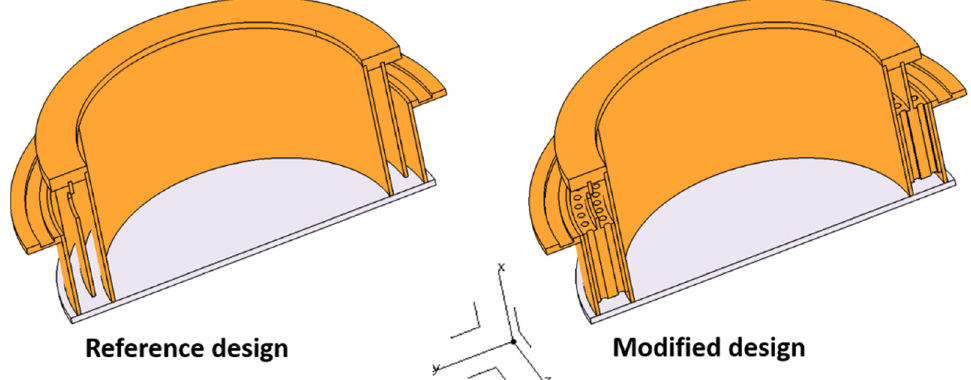
Figure 2. Conceptual design change in the window